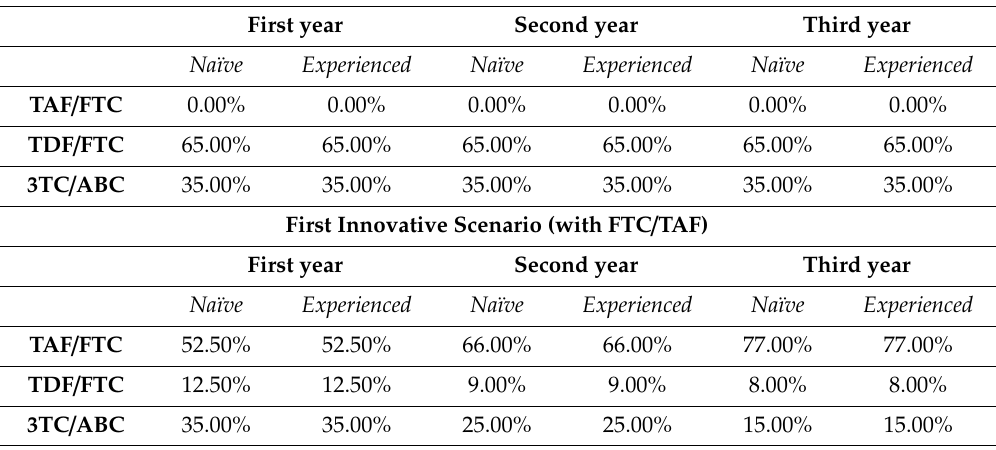
Table 1. Market share of the three considered regimens in three di ff erent scenarios. Source: Expert opinion based on real-world evidence on